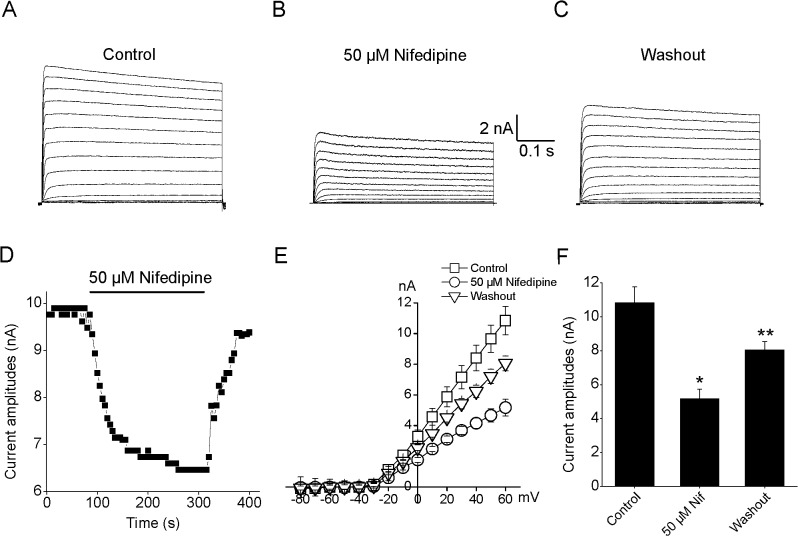
Nifedipine reversibly inhibited macroscopic Kv2.1 currents.Whole-cell Kv2.1 currents were elicited during 500 ms voltage steps to potentials ranging from -80 to +60 mV in the absence of nifedipine. (B) Exposure to 50 μM nifedipine significantly reduced the Kv2.1 currents. (C) After washout, Kv2.1 currents were partial and significant recovery. (D) The time course of inhibitory actions of nifedipine (n = 6). (E) Current-voltage (I-V) curves of the absence, presence and washout of 50 μM nifedipine (n = 11). (F) Statistical analysis of nifedipine effects at +60 mV (n = 11). *P <0.05 compared with control group and ** P <0.05 compared with the group of nifedipine treatment.